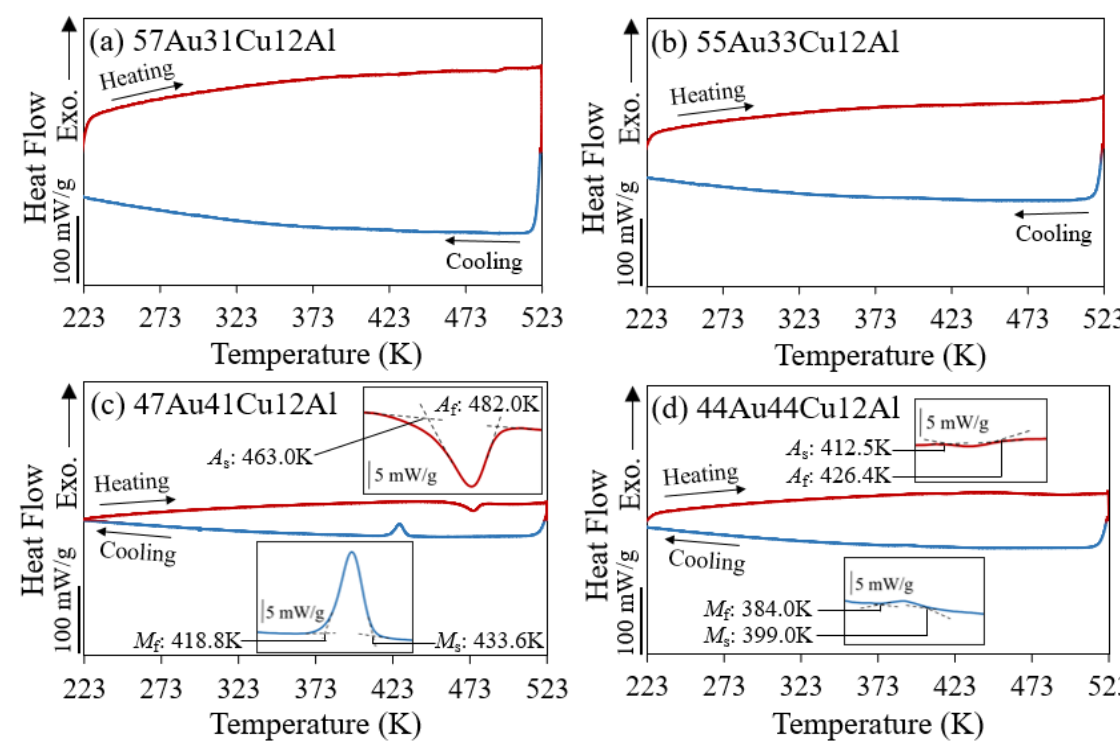
Figure 3. DSC curves of ( a ) 57Au31Cu12Al, ( b ) 55Au33Cu12Al, ( c ) 47Au41Cu12Al, and ( d ) 44Au44Cu12Al alloys. The inserted figures indicate the enlarged transformation peaks. A s , A f , M s , and M f indicate the austenite (reverse martensite) transformation start temperature, austenite transformation finish temperature, martensite transformation start temperature, and martensite transformation finish temperature, respectively.